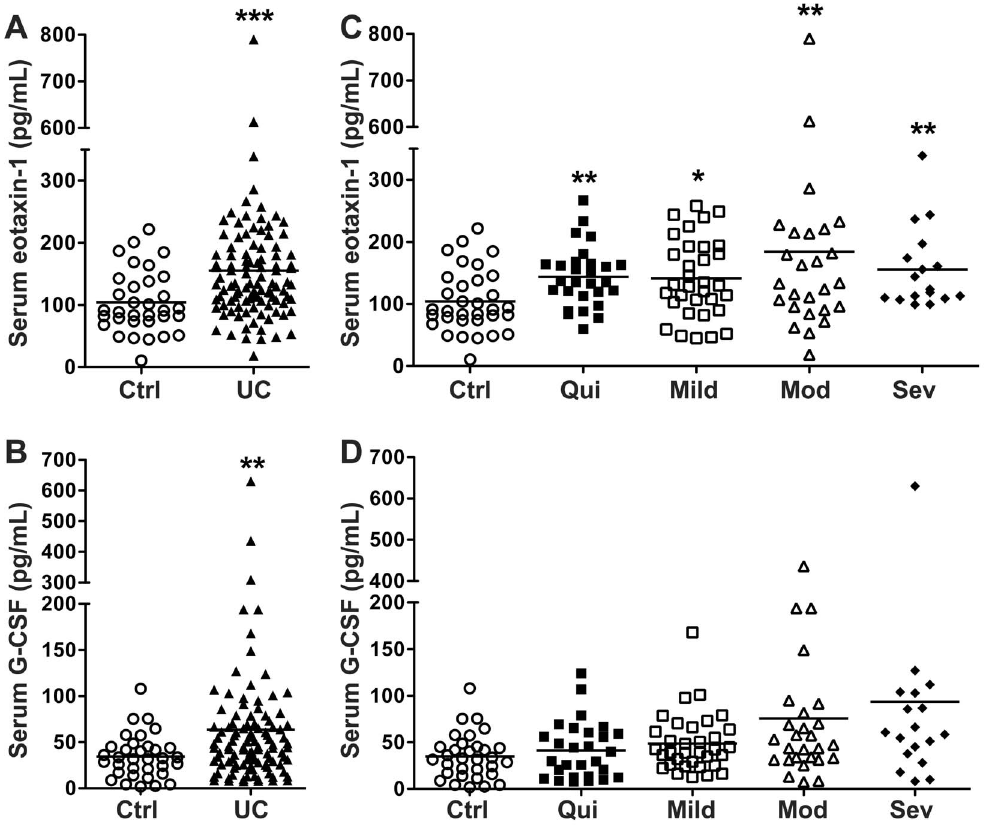
Figure 1. Serum analytes increased in UC, as measured using Luminex technology. Blood was obtained from each subject and processed within 30 min to obtain serum. Disease categories are based on maximal tissue histopathology. n =34 for control (Ctrl) and n =109 for UC. (A) Eotaxin- 1 and (B) G-CSF concentrations in control and all UC patients. (C) Eotaxin-1 and (D) G-CSF concentrations in sera from UC patients stratified by histologic disease severity, and from control subjects. ** p , 0.01; *** p , 0.001 vs. control.